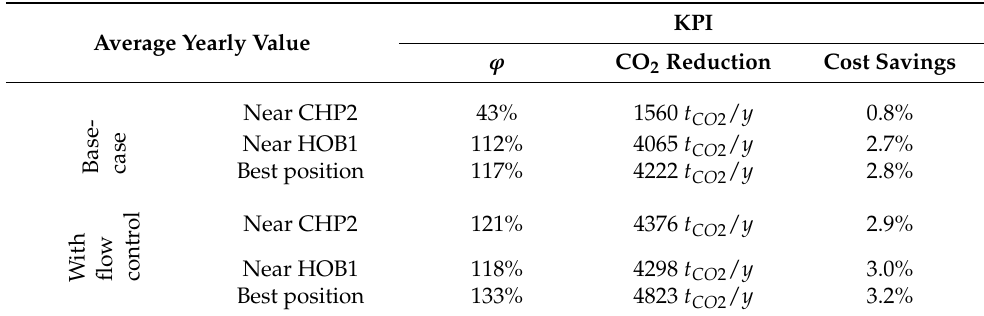
Table 1. Summary of the values assumed by the different parameters adopted in the analysis in different locations of the